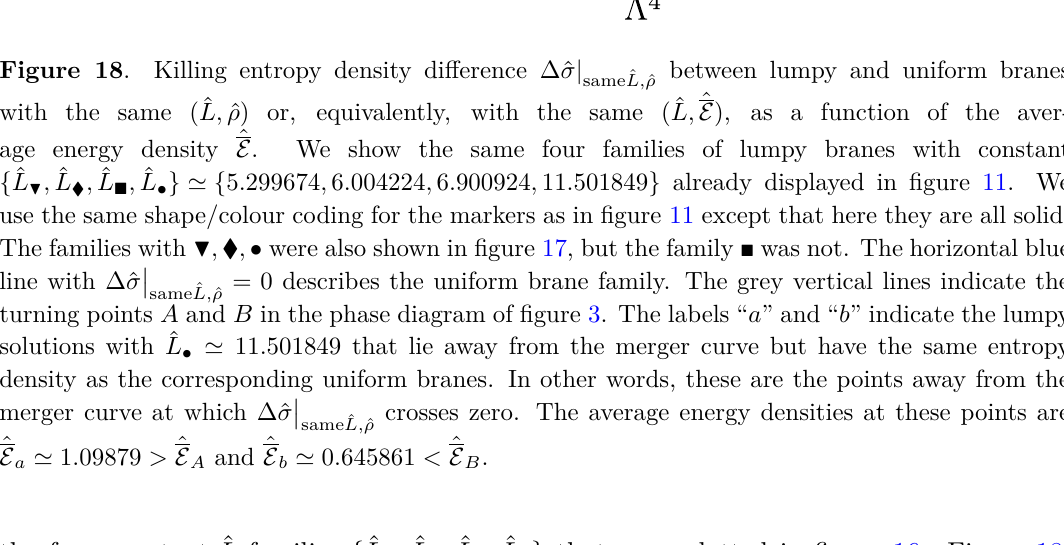
between lumpy and uniform branes L, ˆ ρ ˆ E ) , as a function of the aver-